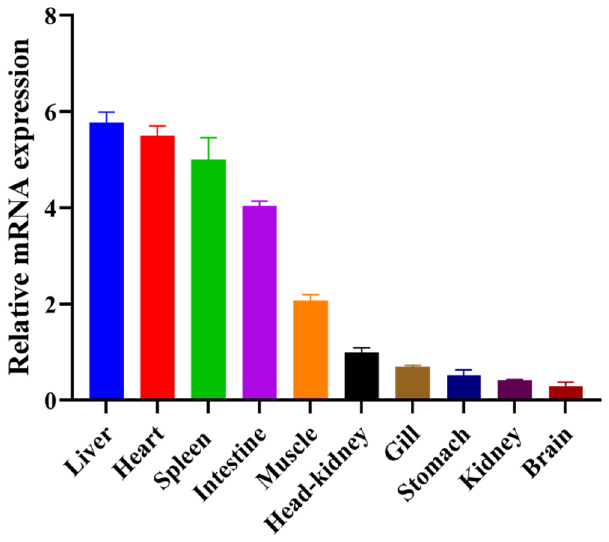
Figure 3. The expression of GHRb mRNA in different organs was detected by qRT-PCR. The expression levels of the ten organs relative to the head-kidney. The data are presented as mean ± SD.